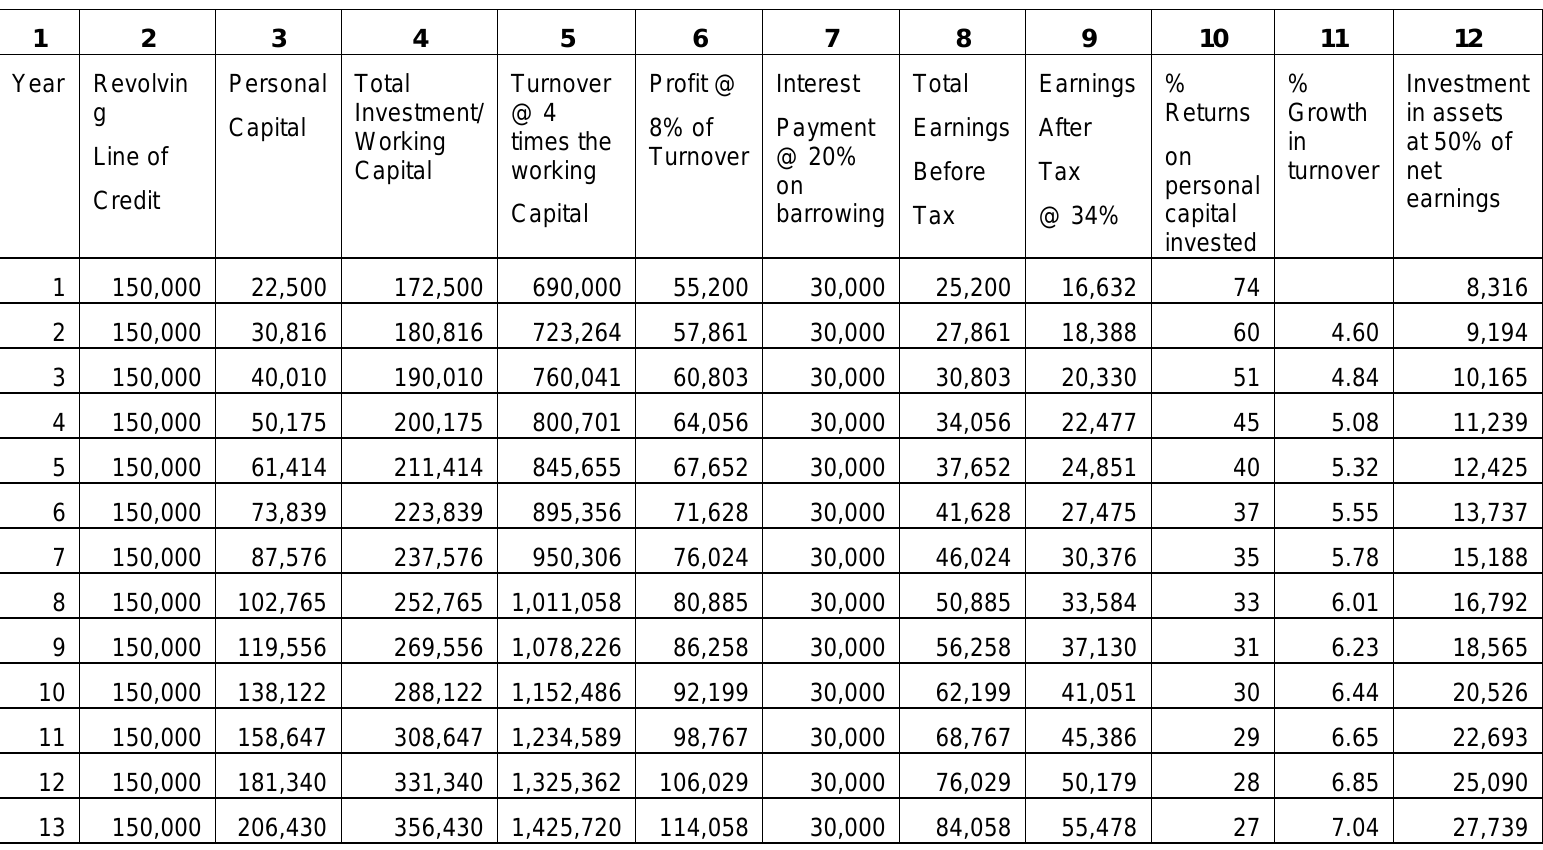
Table 1 : Company funded by the Line-of-Credit